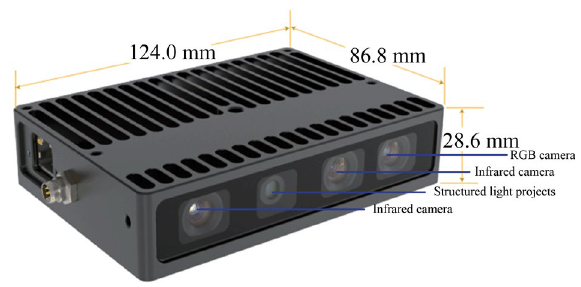
Figure 7. Structure of the Percipio FM851-E2 vision sensor.